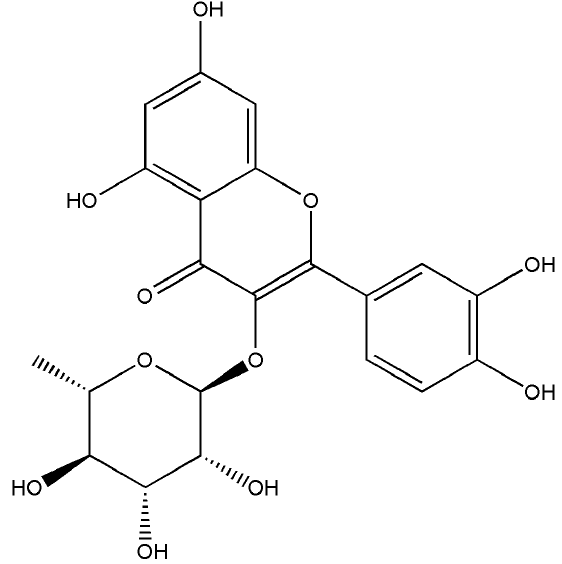
Figure 1. The chemical structure of